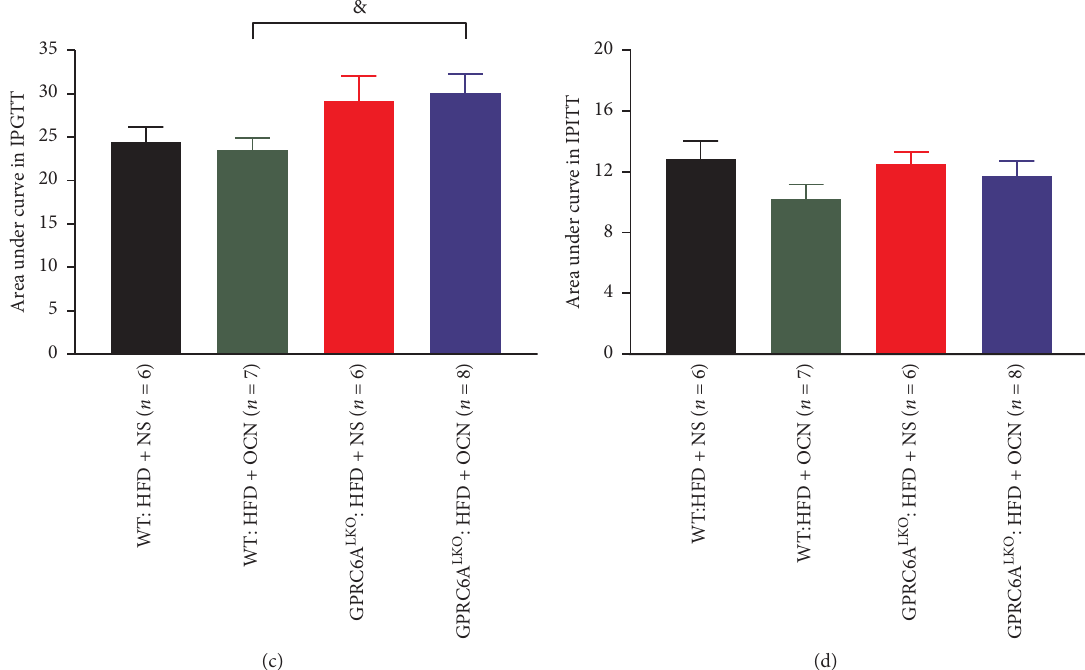
Figure 2: The effects of osteocalcin and GPRC6ALKO on glucose tolerance and insulin sensitivity. (a), (c) Blood glucose levels in each time point and the area under curves in the intraperitoneal glucose tolerance test. (b), (d) Blood glucose levels in each time point and the area under curves in the intraperitoneal insulin tolerance test. Data were expressed as the mean ± SEM and were analyzed using independent- samples T -test. # P < 0 . 05, the GPRC6ALKO :HFD+ NS group compared with the WT:HFD +NS group; & P < 0 . 05, the GPRC6ALKO: HFD +OCN group compared with the WT :HFD +OCN group. GPRC6ALKO, liver-specific conditional GPRC6A knockout; WT, wild- type; NS, saline solution; HFD, high-fat diet; OCN, osteocalcin. The effects of osteocalcin and GPRC6ALKO on HFD-induced hepatic